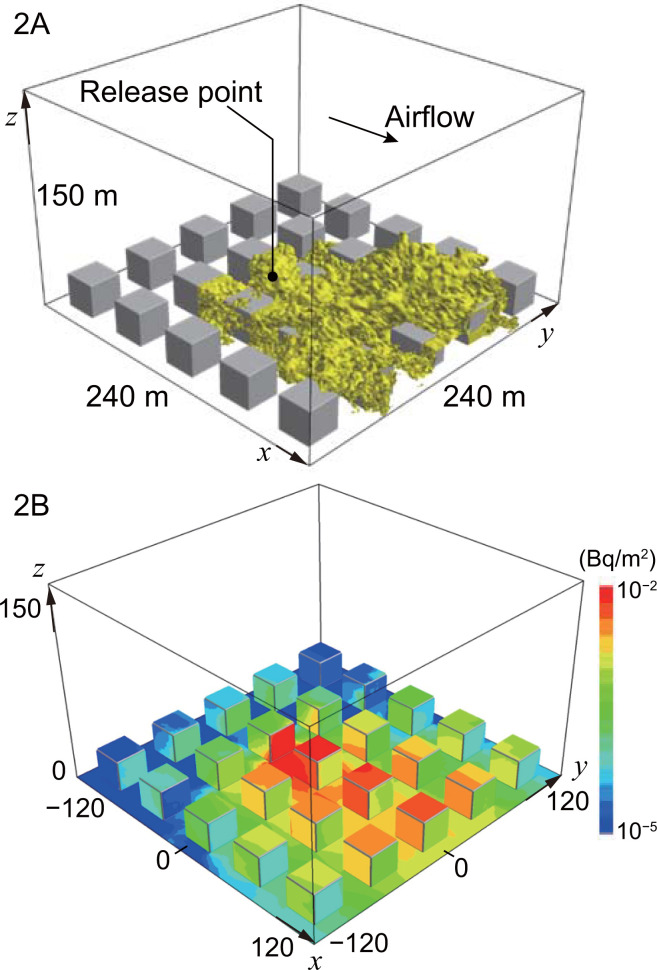
Distribution maps of activity concentrations in building arrays simulated by LOHDIM-LES.The upper panel represents the atmospheric dispersion of 137Cs for case 2A. The yellow areas on the iso-surface indicate 0.01% of the initial concentration. The lower panel depicts the deposition of 137Cs on the ground, building walls, and roofs for case 2B.